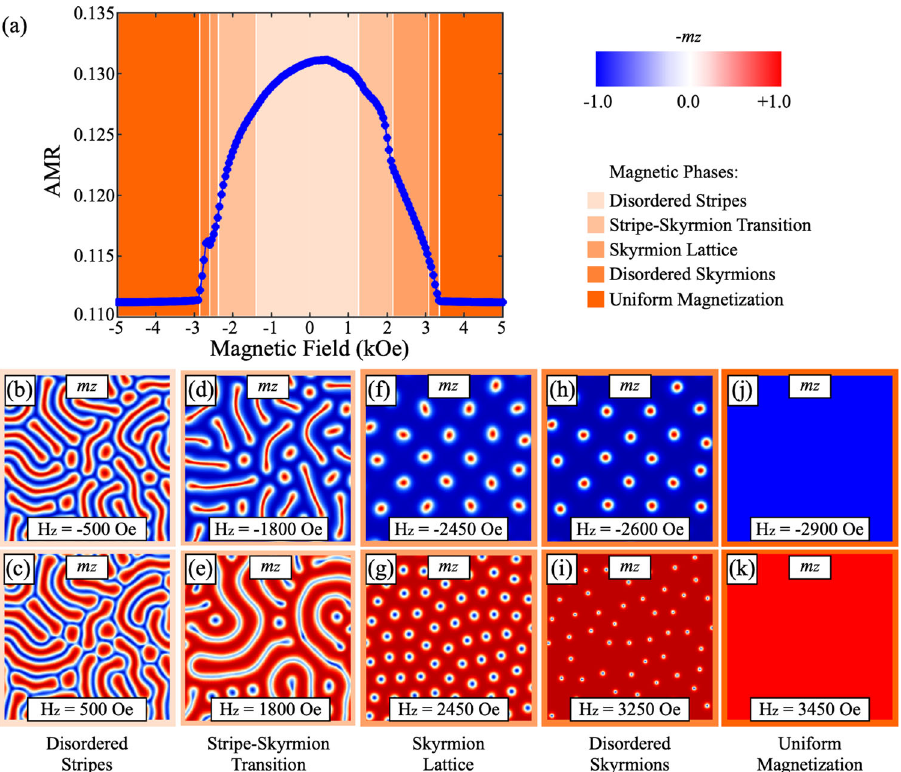
Fig. 4 Micromagnetic modeling of domain morphology and anisotropic magnetoresistance. a Field-dependent calculated anisotropic magnetoresistance (AMR) obtained from processing equilibrium states stabilized on a 10 μ m × 10 μ m × 80 nm slab with 10 nm tetrahedra, and magnetic properties: saturation magnetization, M S = 400 emu/cm 3 , uniaxial anisotropy, K U = 4 × 10 5 erg/cm 3 , and exchange length, A ex = 5 × 10 − 7 erg/cm. Overlaid on (a) are the respective fi eld-dependent magnetic phases (disordered stripes, stripe-skyrmion transition, skyrmion lattice, disordered skyrmion, uniform magnetization). b – k Equilibrium states, at different perpendicular fi elds, illustrate the top-side view of the magnetization along the z -axis ( m z ) at the top surface of the slab ( z = 40 nm). The perpendicular magnetization ( m z ) is represented by regions in red ( + m z ) and blue ( − m z ), while the in-plane magnetization ( m x , m z ) is represented by white regions. Each image depicts a 2 × 2 μ m fi eld of view near the center of the 10 × 10 μ m total area. The colorbar details the ( m z ) magnetization polarity detailed in the equilibrium helicity (color) Bloch-lines on opposite stripe domain walls, while a Bloch point is represented by a white-colored feature on a domain wall where the helicity of the Bloch-line changes from left-to-right or vice versa along the length of the domain wall. The recon fi guration/merger of chiral-to-achiral spin textures results in a local change of chirality for the domain morphology, which takes places near/at fi elds at which the second anomaly is observed [Fig. 5d, e]. Also noted, under applied fi elds, is the local rerrangement of Bloch-lines within each stripe [Fig. 5r – t], which is possible due to the displacement of Bloch-points in the stripe